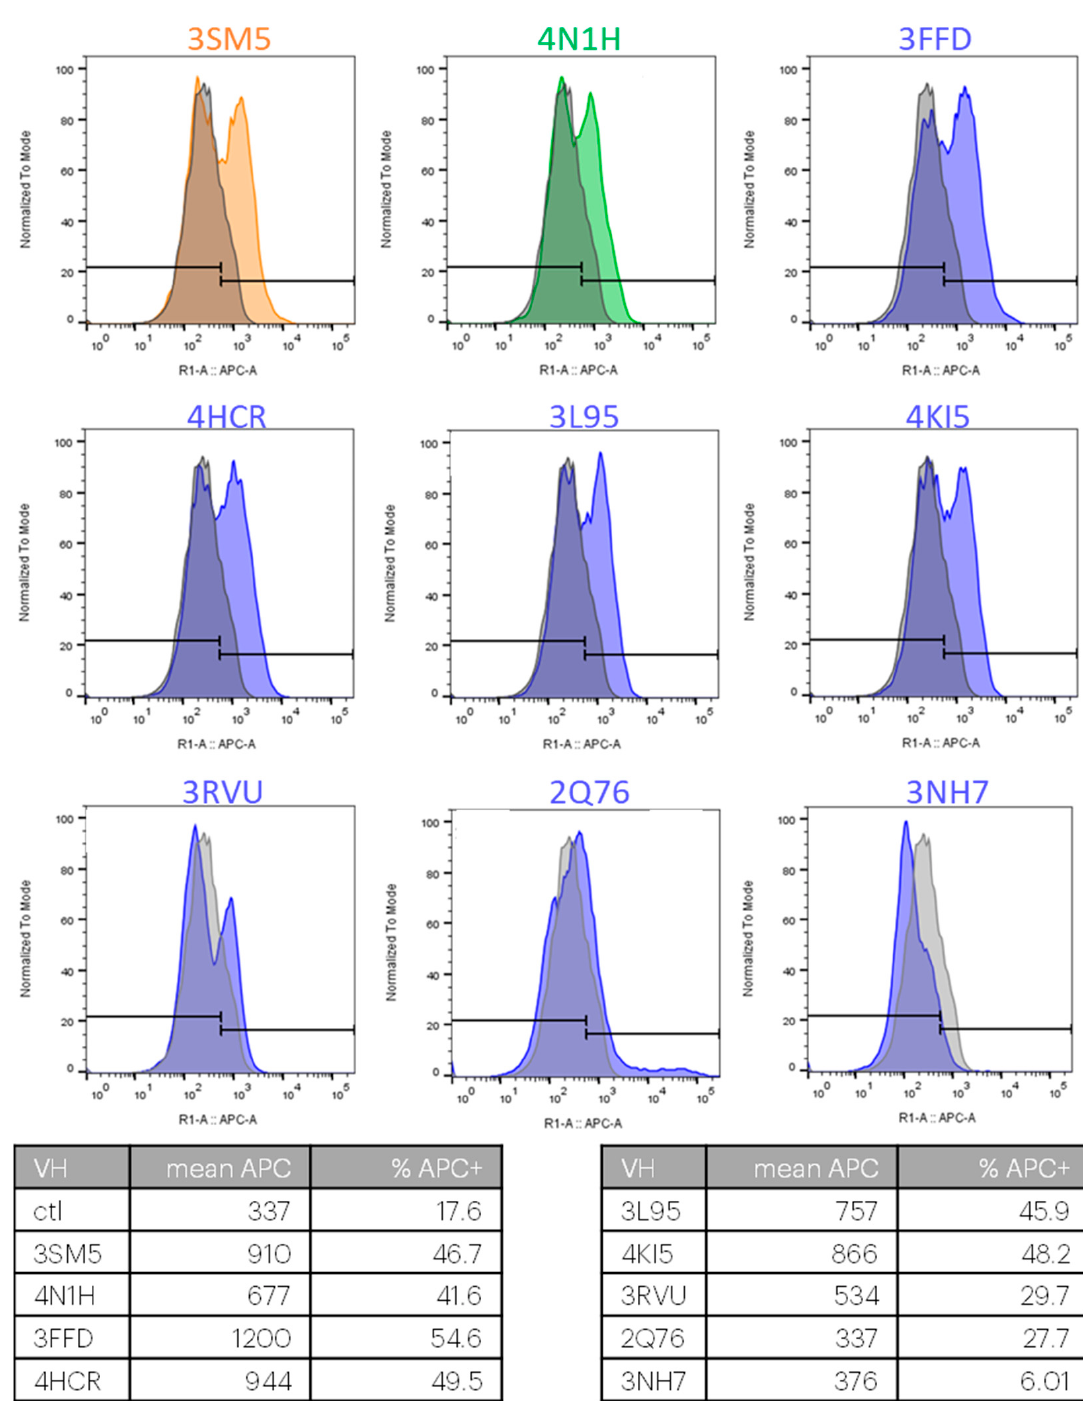
Figure 1. Binding of VH and VHH domains to CXCR4 expressing cells. Nb were produced in a cell-free system. All Nb were incubated with hCXCR4-overexpressing cells and revealed by an APC-conjugated anti-His antibody. The binding of a control Nb is shown in gray.